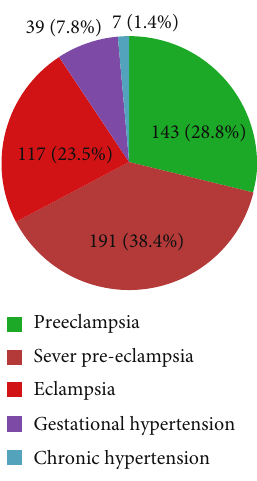
Figure 1: Maternal diagnosis during admission among mothers with HDP from July 01, 2014, to June 31, 2019, at Suhul Hospital, Northwest Tigray, Ethiopia,